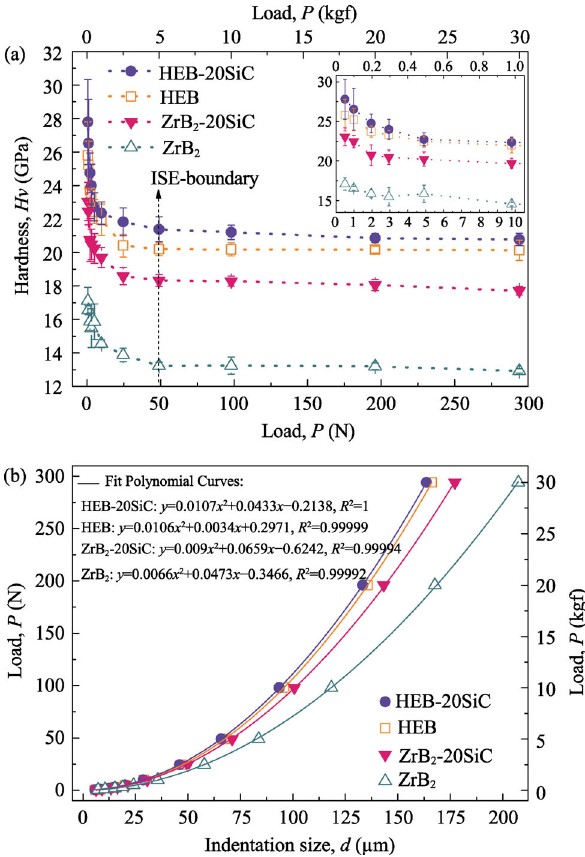
Fig. 3 Vickers hardness of HEB, HEB–20SiC, ZrB 2 , and ZrB 2 –20SiC ceramics under different indentation loads: (a) Hv –load curves; (b) the fit polynomial curves of the load–indentation size